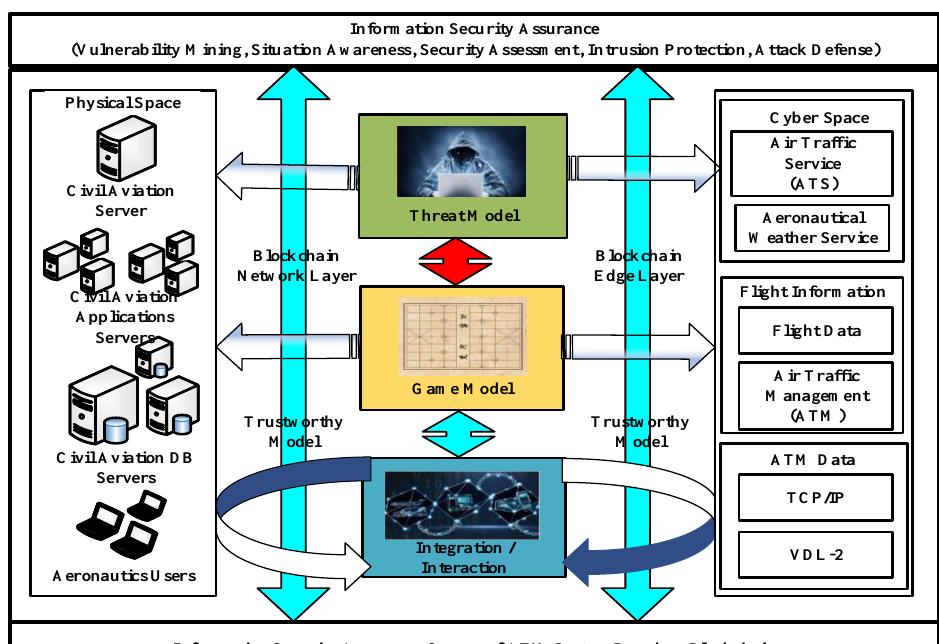
Figure 4. The overall research proposal.